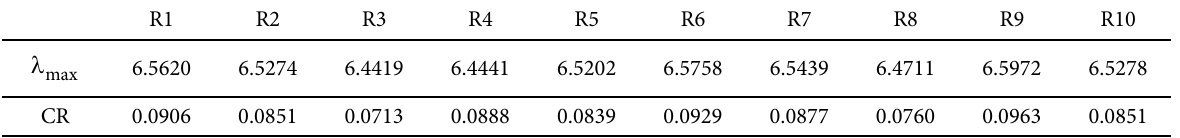
Table 8. The largest eigenvalue and ratio of consistency per each AHP matrix given by the respondents R1